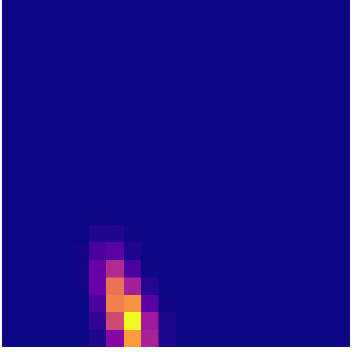
Figure 5. Typical persistence